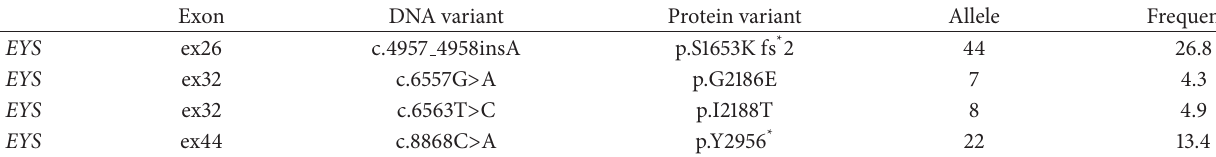
Table 6: Frequency of major EYS variants in 82 probands with EYS mutations.